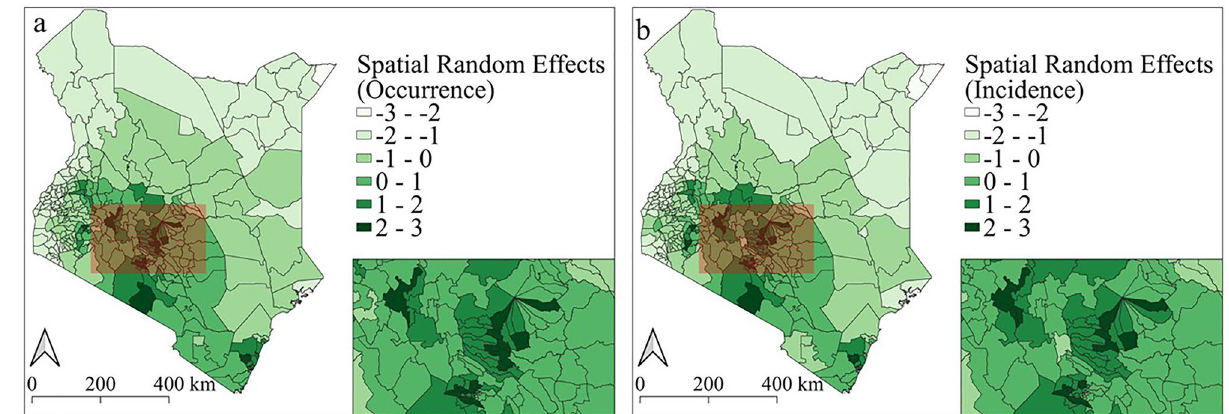
Figure 12. The posterior mean of the spatial random effects. The maps show the posterior mean of the spatial random effects for the occurrence ( a ) and incidence ( b ) models. Maps were generated using Quantum Geographical Information Systems (QGIS) v. 3.16.11 (https:// www. qgis. org/ en/ site/ forus ers/ downl oad. html).